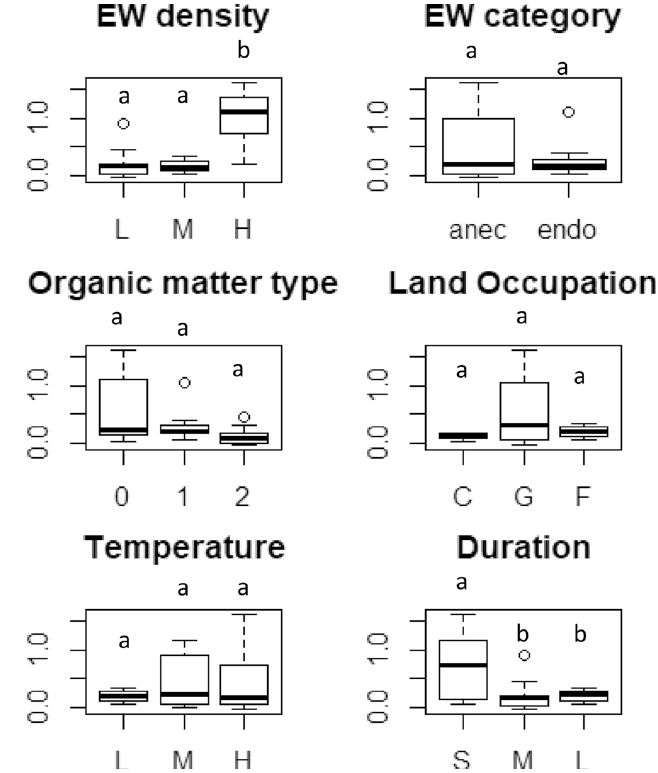
Figure 2. Impact of the factors on the logarithm ratio of CO 2 emissions with and without EW. To build the box plot, each of the factors was split into 2 or 3 intervals*. All the experiments in the database measured